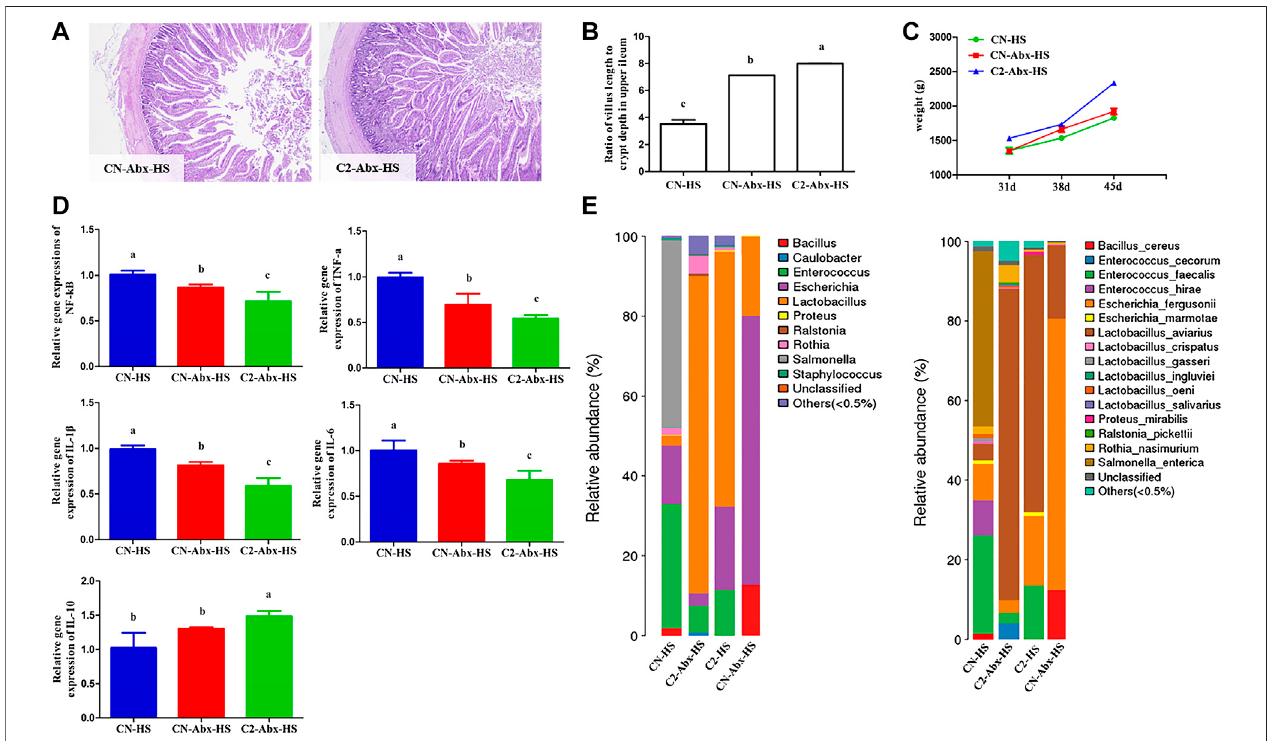
FIGURE5| Preventiveeffectsof1,8-cineolemicrocapsulesonintestinalmicrobiotamediateheatstressinducedweightlossandin fl ammation.n (cid:2) 6.Notes: (A) the pathological sections of CN-Abx-HS and C2-Abx-HS. (B) Ratio of villus length to crypt depth in upper ileum after treatment with heat stress and antibiotic cocktail. (C) Weight changes after 31, 38, and 45 d. (D) Low-grade in fl ammation (NF- κ B, TNF- α , IL-1, IL-6, and IL-10) expression. (E) Changes inbacteriagenus and species under CN-HS, CN-Abx-HS, C2-HS, and C2-Abx-HS treatment. Data are expressed as means ± SD, and statistical analysis was performed by ANOVA with a post hoc Bonferroni ’ s multiple-comparison test. a, b represent signi fi cant differences on the same row ( p < 0.05); n (cid:2) 6.